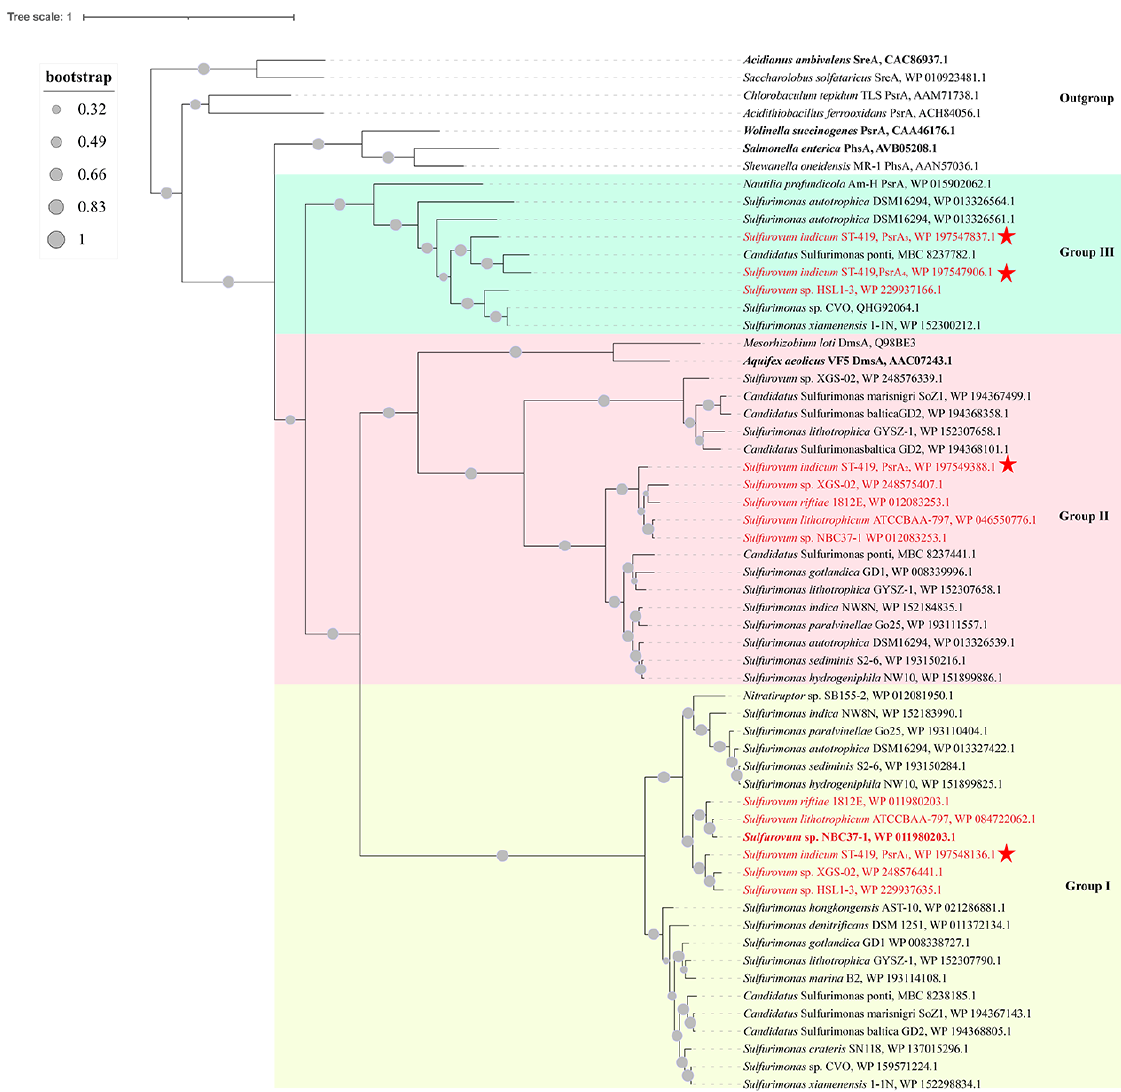
Figure 7. Phylogenetic relationships of putative PsrAs from strain ST-419 with various sequences of the sulfur reductase/polysulfide reductase/thiosulfate reductase family. The polysulfide reductase present in cultured strains of the genus Sulfurovum are shown in red and the homologous genes in strain ST-419 are marked with an asterisk. Biochemically characterized enzymes are shown in bold. The red stars represented the polysulfide reductases of strain ST-419. Amino acid sequences were derived from the non-redundant protein database of NCBI and accession numbers are shown in the rear. Bootstrap values based on 1000 replicates are shown at branch nodes. Bar = 1.0 substitutions per protein position.